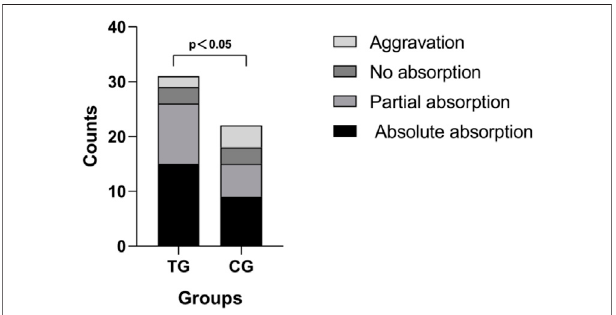
FIGURE 4 | In the treatment group (TG), 15 (48%) cases showed absoluteabsorption,11(36%)showedpartialabsorption,3(10%)showedno absorption, and two showed aggravation (6%); in the control group (CG), 9 (41%) cases showed absolute absorption, 6 (27%) showed partial